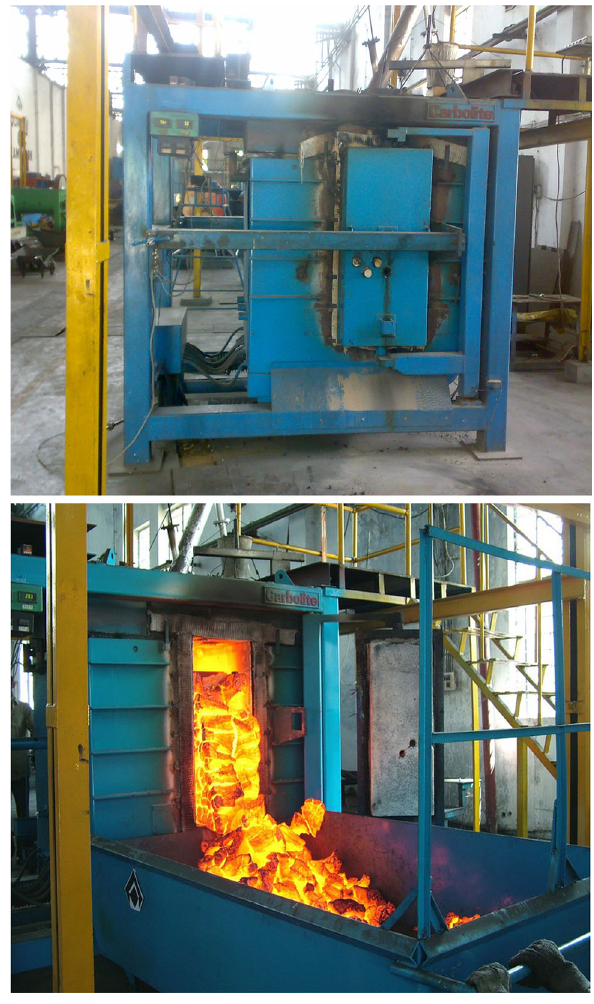
Fig. 2 Photograph of 250 kg pilot coke